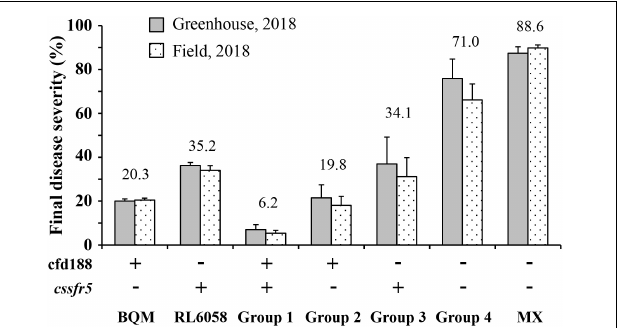
FIGURE 4 | Final disease severities on the RL6058 × BQM F 2 : 3 family groups containing different quantitative trait loci (QTL) combinations. Group 1 plants were positive for both cfd188 and cssfr5 (+ , +), Group 2 plants were positive for cfd188 and negative for cssfr5 (+ , -), Group 3 plants were negative for cfd188 and positive for cssfr5 (-, +), and Group 4 plants were negative for both cfd188 and cssfr5 (-, -). Tests were conducted under greenhouse conditions and in the field of Southern Gansu Province in 2018.